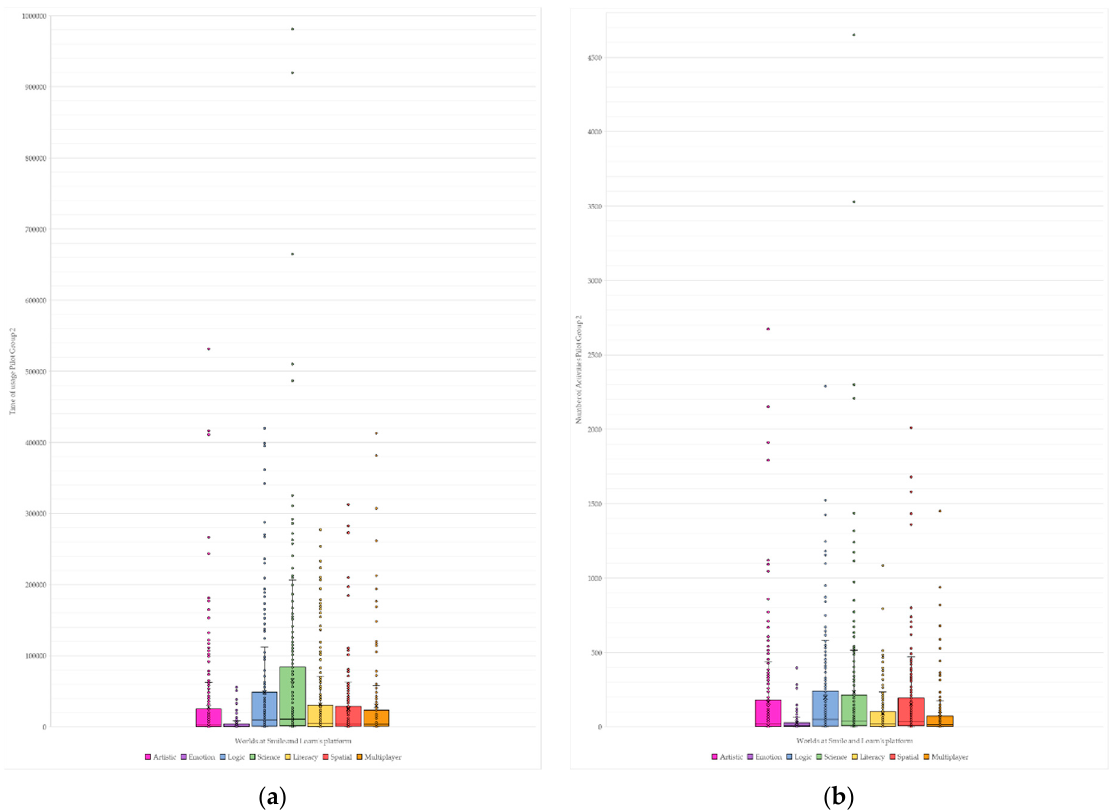
Figure 6. Pilot Group 2’s use of worlds (Arts, Emotion, Logic, Science, Literacy, Spatial, Multiplayer) at Smile and Learn’s platform. ( a ) General time of usage (seconds) with the platform for Pilot Group 2; ( b ) General number of activities played by Pilot Group 2 with the